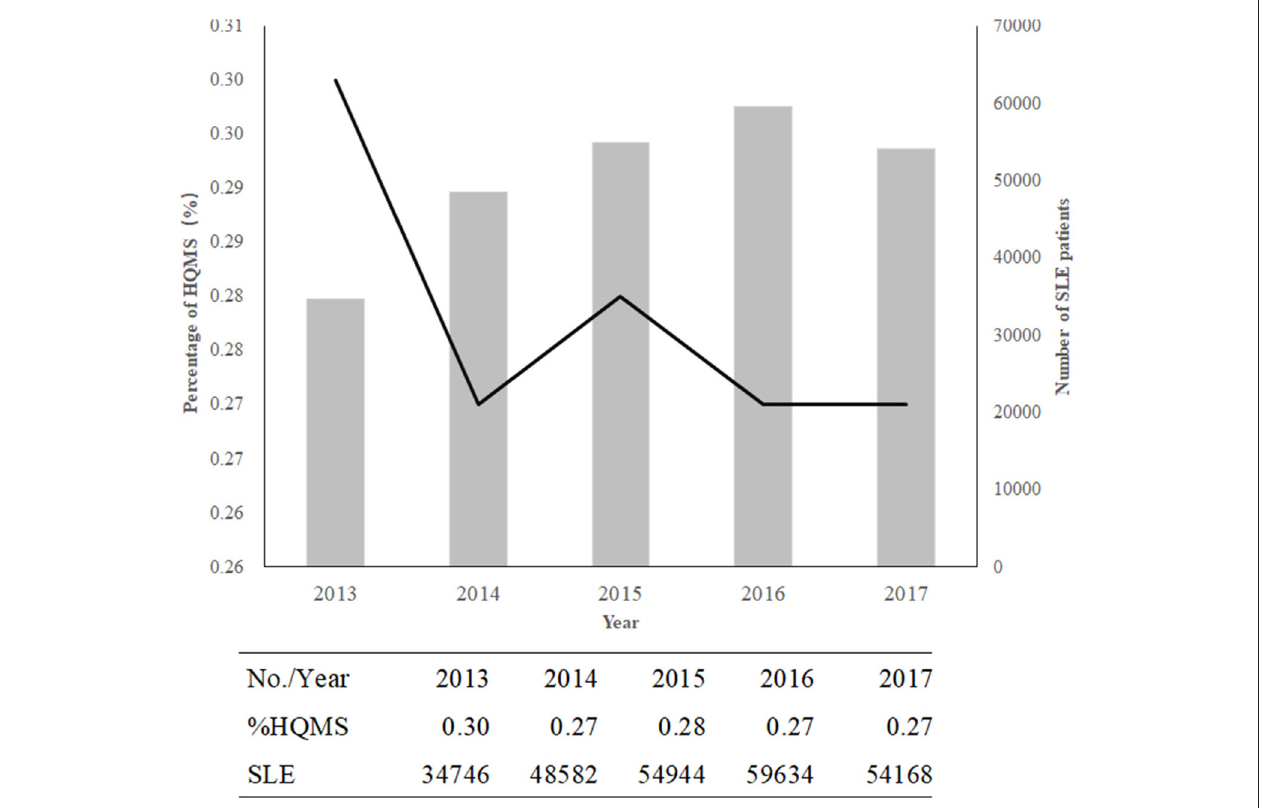
FIGURE 1 | The decreasing trend in SLE in China from 2013 to 2017. The columns indicate the numbers of patients with SLE; the line shows the percentage of SLE or lupus in HQMS.